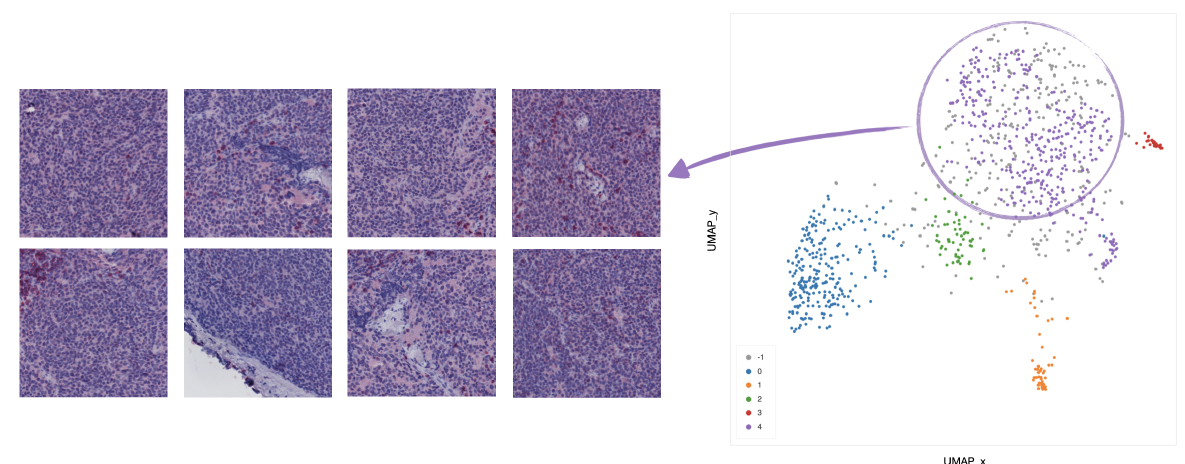
Figure 13. Example of 8 representative tiles with a low level of infiltration in stroma poor areas, grouped as cluster 4 by UMAP and